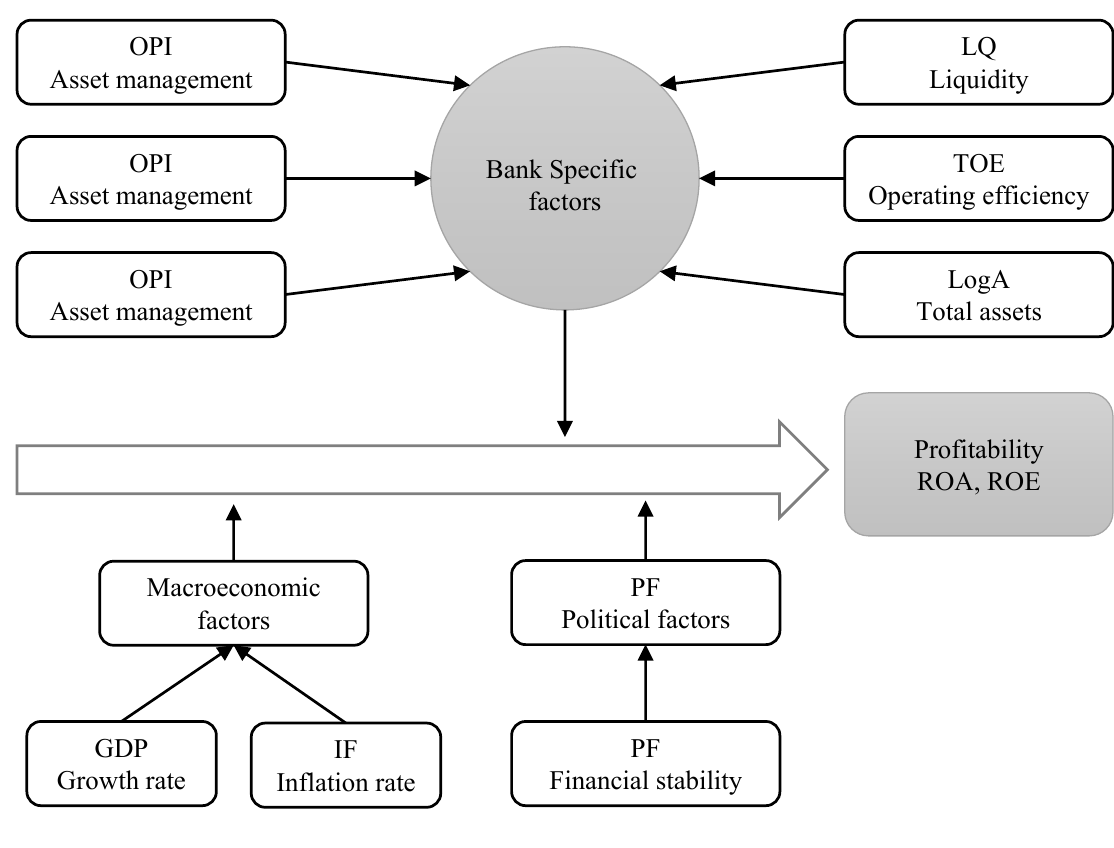
Figure 1. Study framework for all